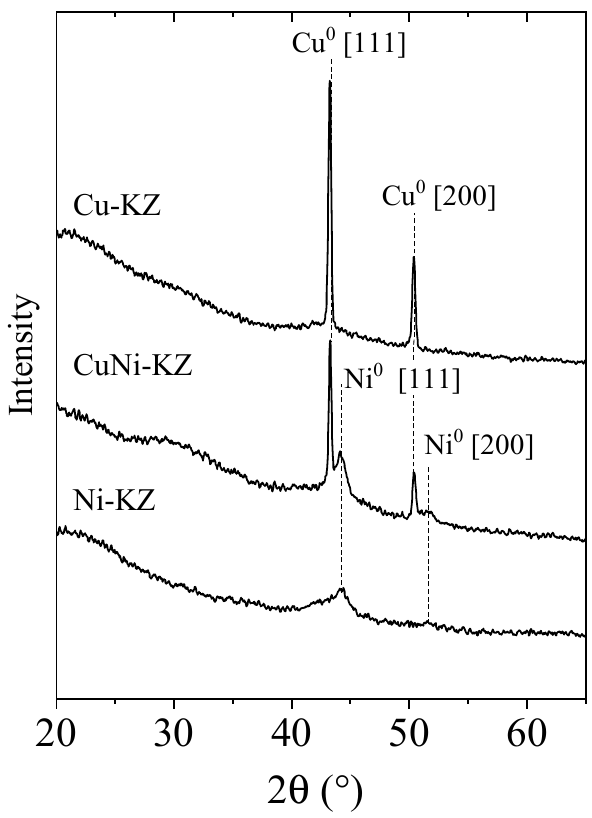
Figure 2. XRD patterns of the 400 °C reduced KZ composite catalysts.